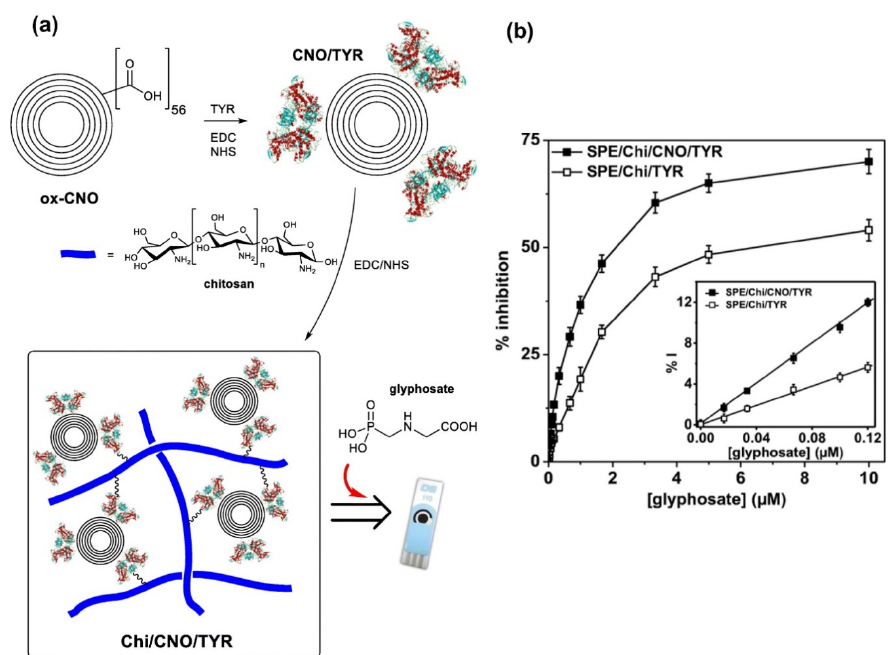
Figure 15. ( a ) Schematic representation of the preparation of SPE /Chi/ CNOs/TYR electrodes to develop a GLYP sensor. ( b ) Calibration plots for SPE/Chi/CNO/TYR and SPE/Chi/TYR at different glyphosate concentrations. Reprinted with permission from [150]. Copyright 2019 Springer.